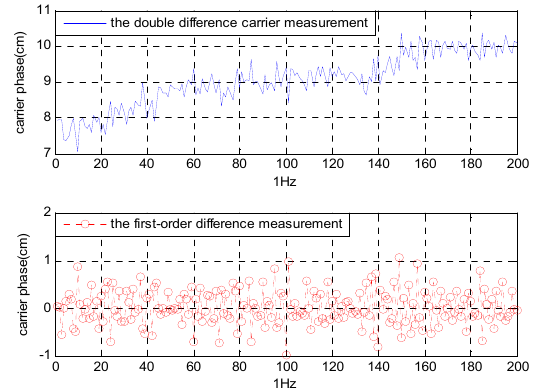
Figure 6. The noise error of the DD carrier measurement.